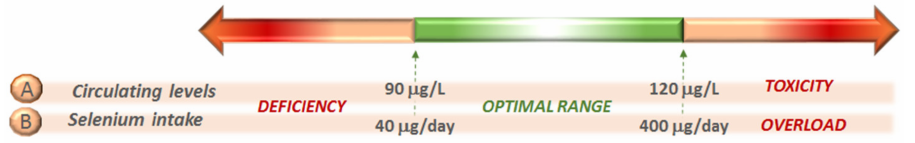
Figure 2. ( A ) Narrow range of adequate blood Se concentration, levels below and above, risk of deficiency and toxicity, respectively. ( B ) Recommended daily intake of Se, below and above, risk of adverse effects on